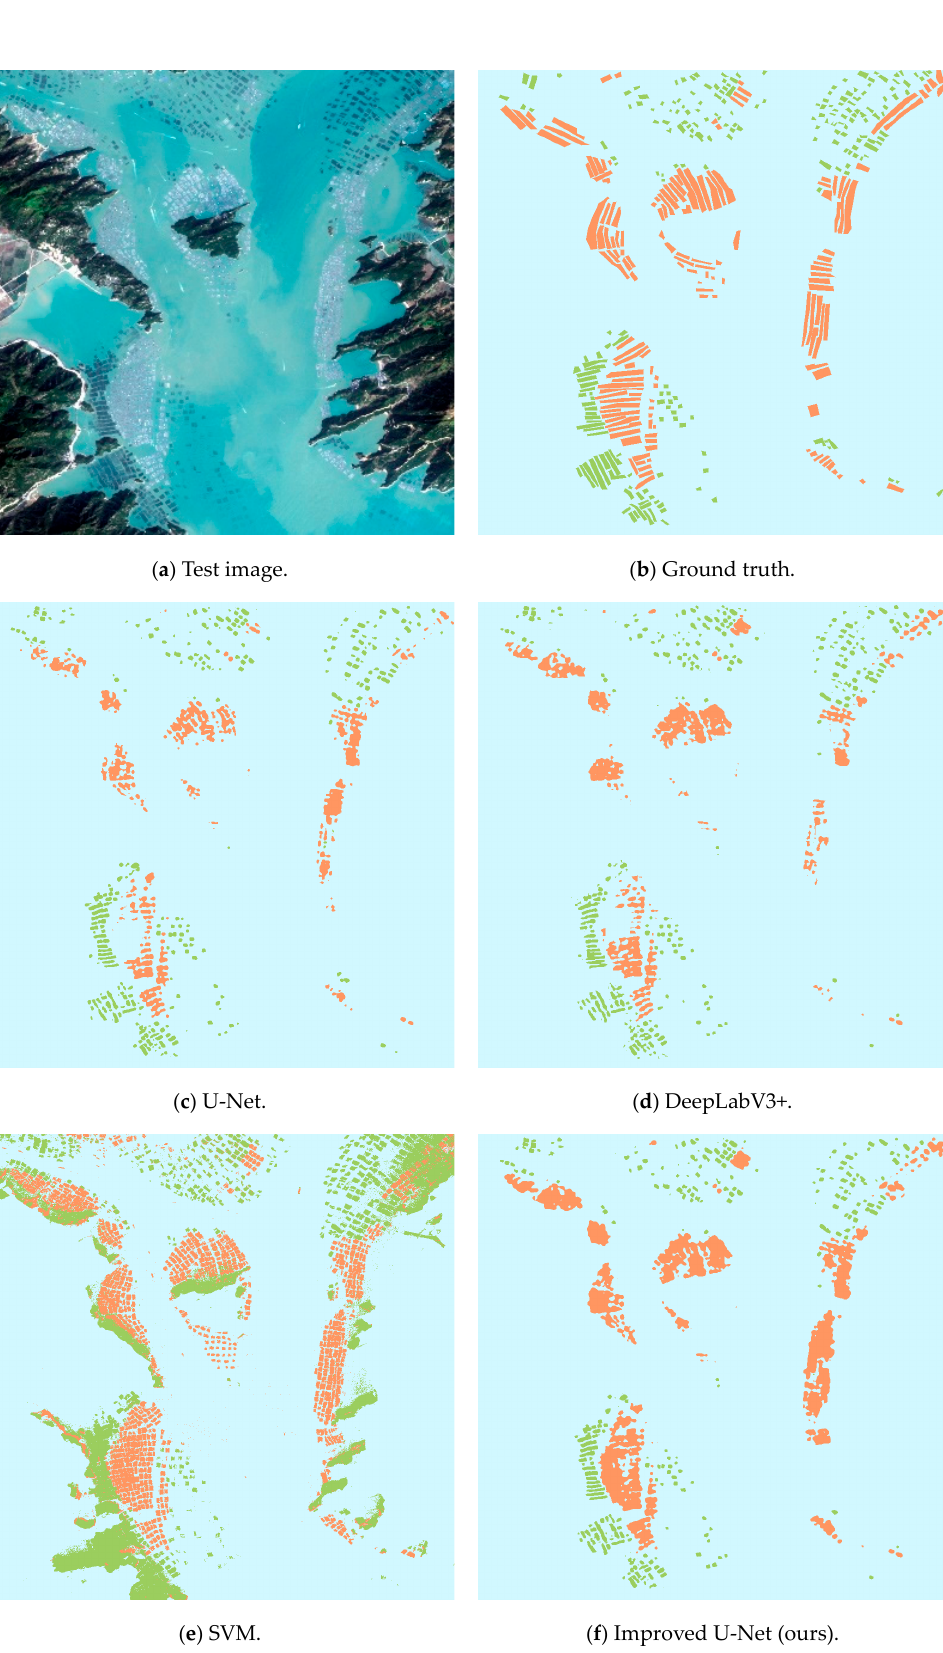
Figure 6. Comparison of classification results of different models in typical areas of the study area. The orange area in the figure represents the cage aquaculture area; the green area represents the floating raft aquaculture area; and the blue area represents the